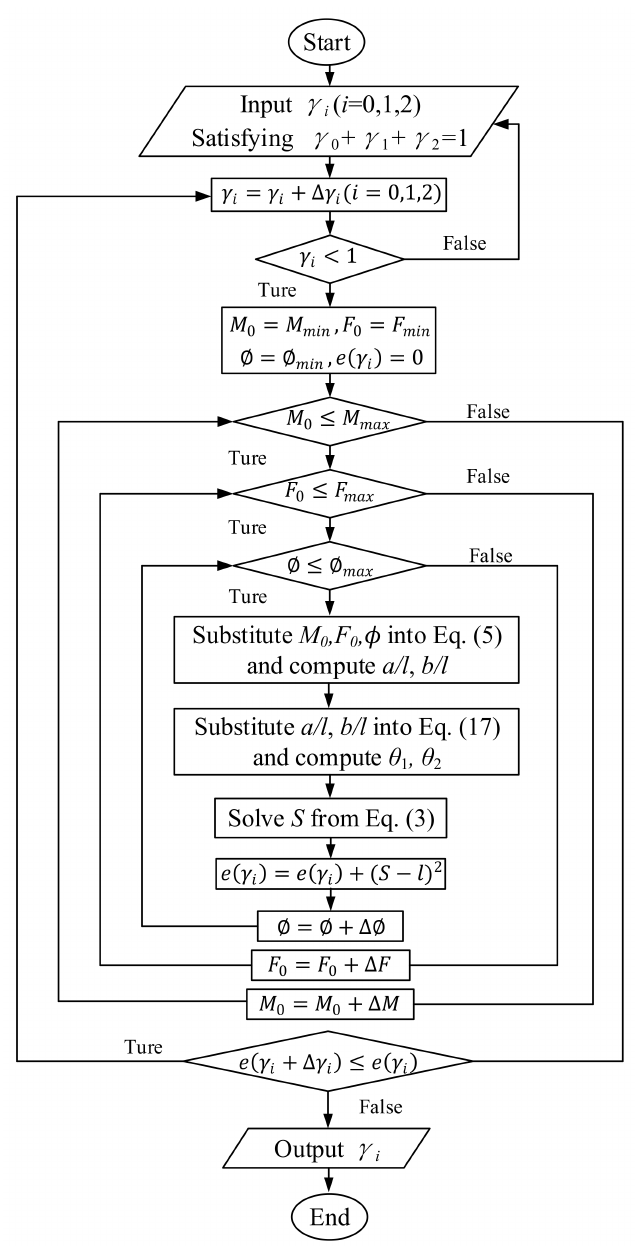
Figure 7. Optimization procedure chart for obtaining the spline PRBM’s characteristic